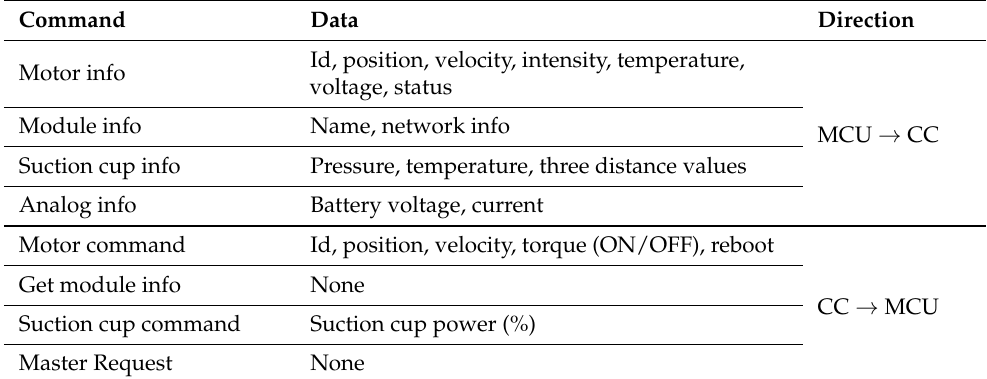
Table 1. Main messages between